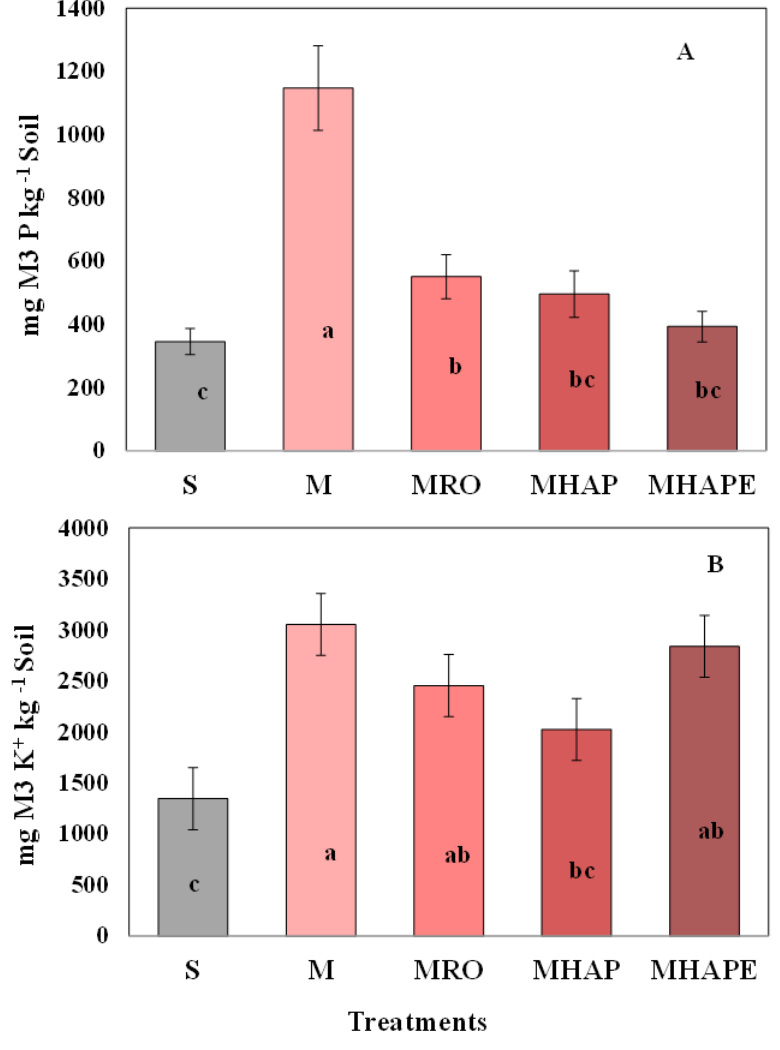
Figure 4. The effect of treatments on Mehlich3 (M3) extractable corn soil P ( A ) and K ( B ) concen- trations. The mean was calculated for n = 4; the vertical bar represents the standard deviation of the mean. Here, S = soil control; M = manure control; MRO = manure + red oak biochar; MHAP = manure + corn feedstock autothermal porous Fe-engineered biochar; MHAPE = manure + corn feedstock autothermal porous Fe-engineered biochar. Different letters show the treatments that are statistically different at p < 0.05 level.